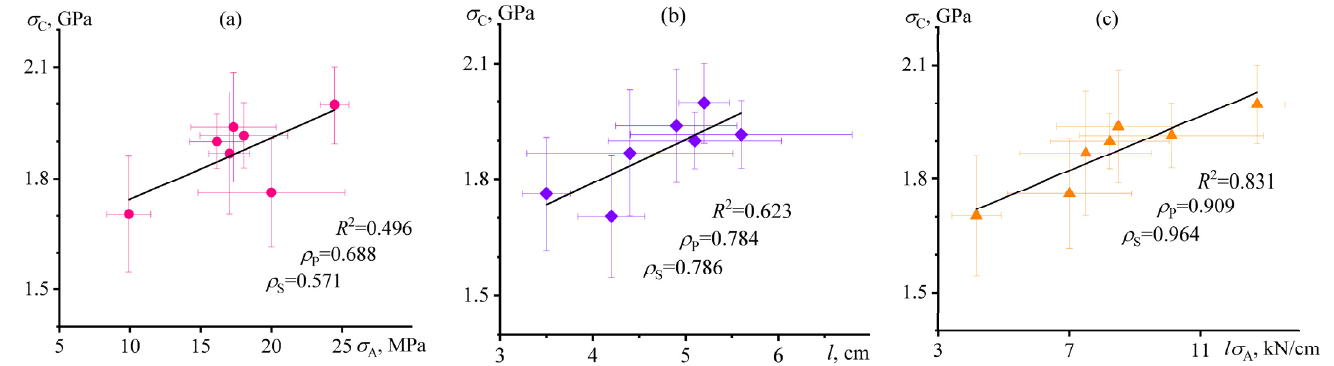
Figure 14. Dependences of the tensile strength of carbon-fiber-reinforced epoxy plastics on the fiber–matrix adhesion strength ( a ), the efficiency (length) of carbon fiber impregnation with the nanoparticle-containing epoxy binder ( b ), and their product ( c ).